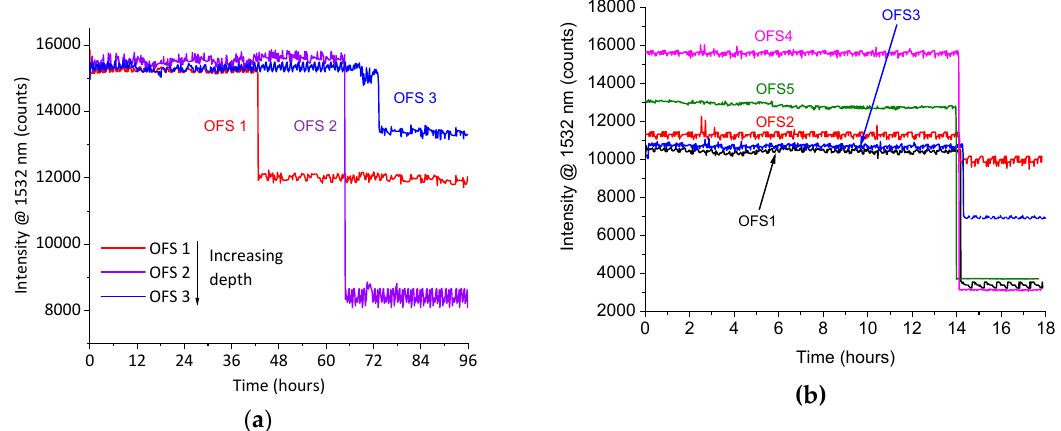
Figure 5. Signal intensity, at a wavelength of 1532 nm, from optical glass sensors embedded in: ( a ) Epoxy at different depths and ( b ) GFRP samples. The samples were immersed in artificial sea water at 80 °C.